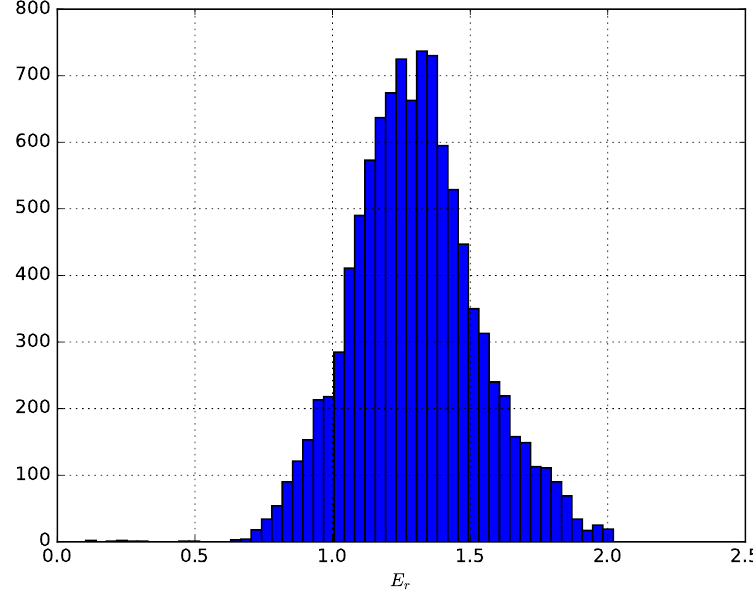
Figure 4. The histogram of embedding rate for